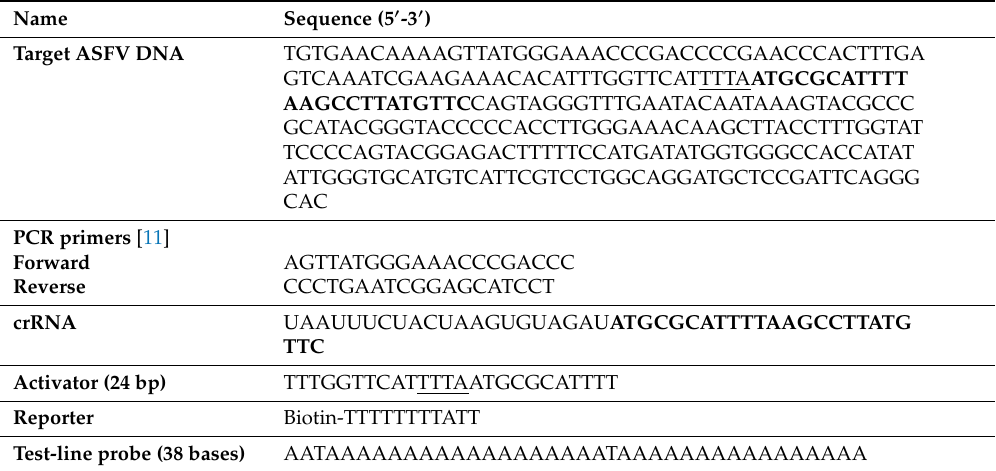
Table 1. Nucleic acids used in this